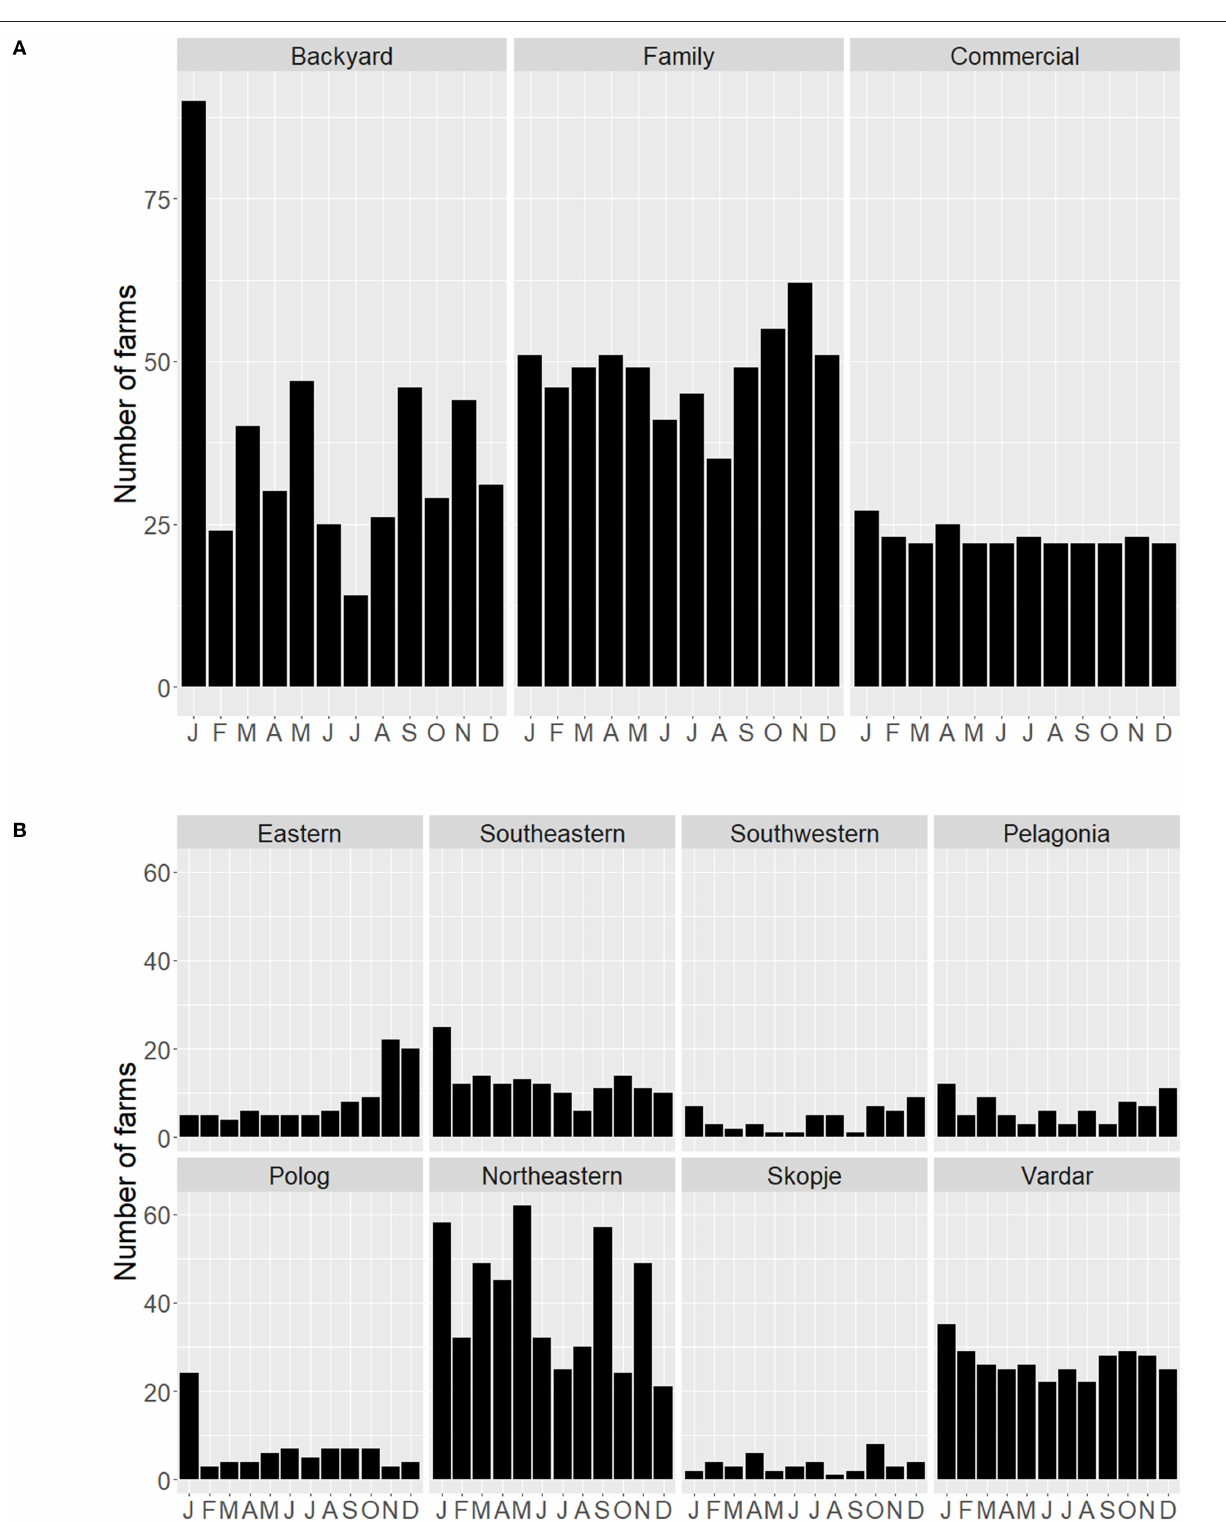
FIGURE 2 | Number of North Macedonian pig farms reporting litters per month by (A) farm type, and (B) region, based on questionnaires administered between September 2019 and March 2020.